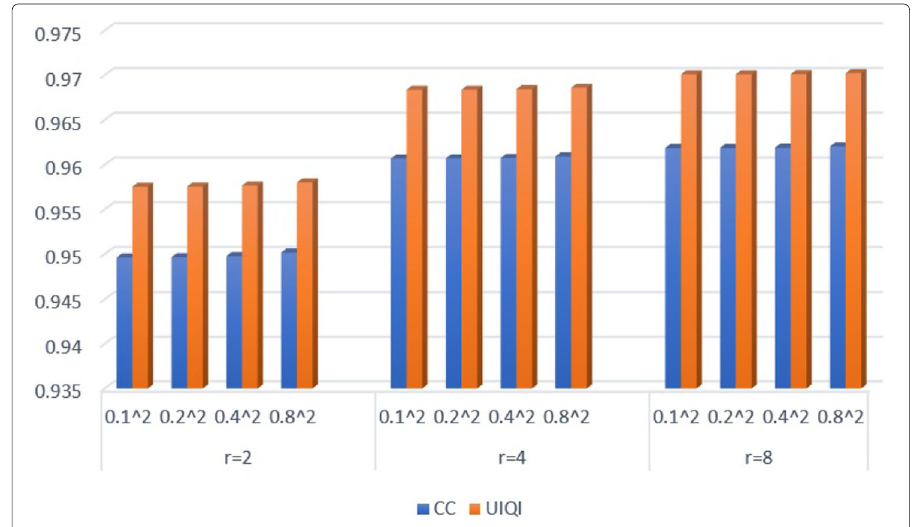
Fig. 3 The influence of the parameters r and ζ on the fusing result concerning CC and UIQI indexes. Higher CC and UIQI indicate the better-fused effect